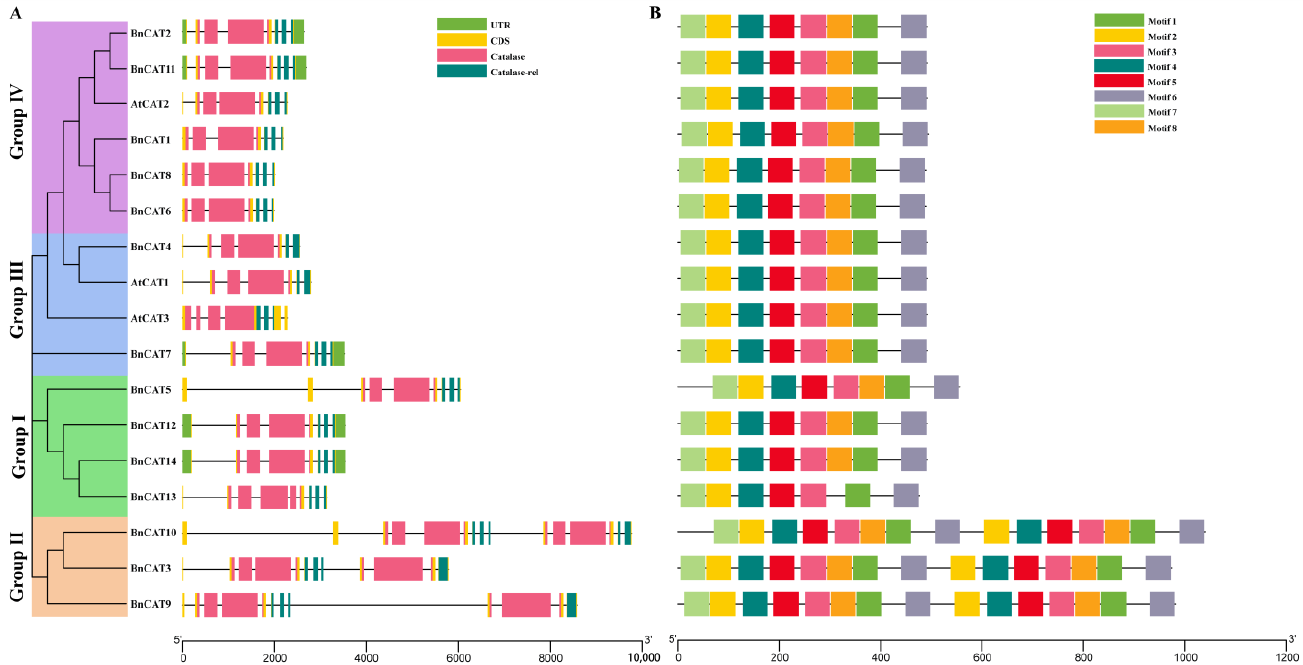
Figure 4. The gene structure and motif analysis of the CAT family genes from B. napus and A. thaliana . According to the phylogenetic relationships, the CAT genes from both genomes were clustered into four groups (Groups I–IV). ( A ) The gene structure of the BnCATs and AtCATs . Light green color shows the UTR regions, yellow color shows the CDS or exons, black horizontal line shows the introns, pink color shows the catalase core domain (catalase, PF00199), and dark green color shows the catalase-related immune-responsive domain (catalase-rel, PF06628). ( B ) Conserved domain structures identified in the BnCATs and AtCATs . Different color boxes show different motifs.